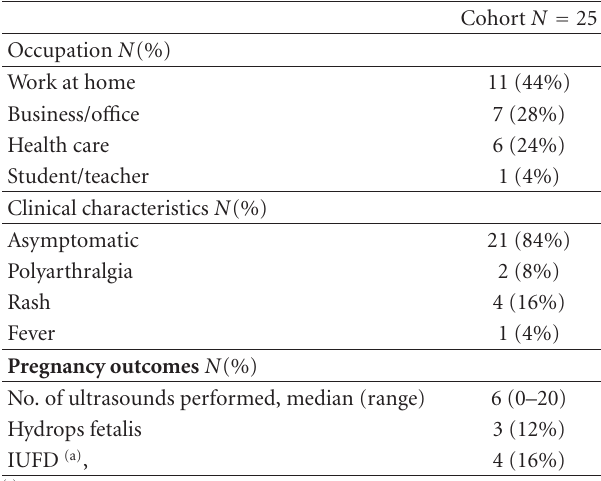
Table 1: Occupation and clinical characteristics of